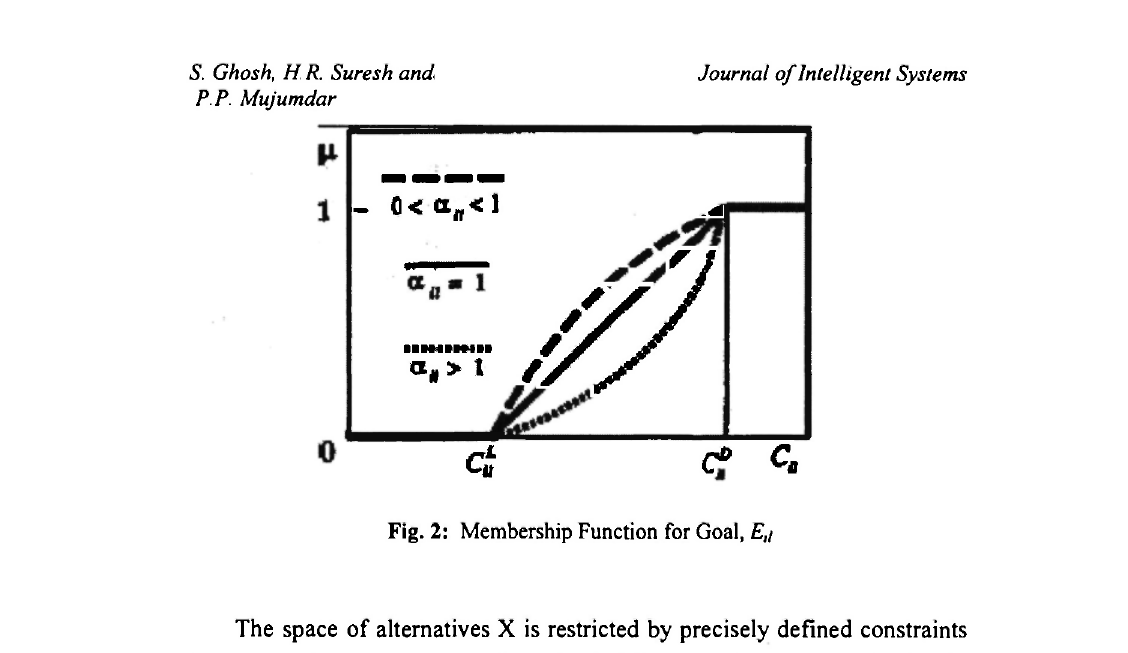
Fig. 2: Membership Function for Goal,